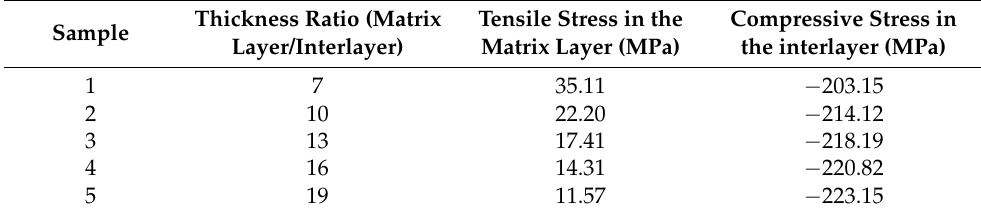
Table 3. Residual stress in laminated ceramics with different layer thickness